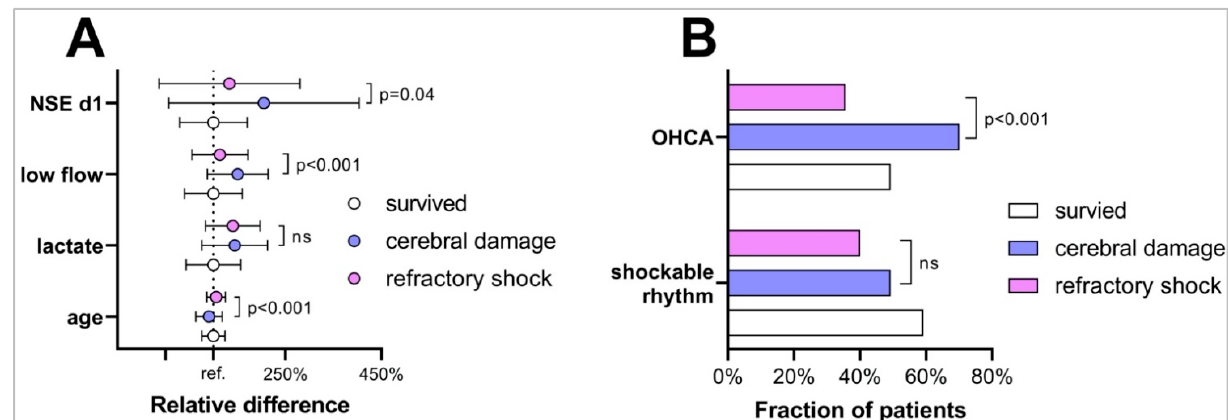
Figure 4. Characteristics of ECPR patients in respect to outcome. ( A ) Relative difference of characteristics of patients dying